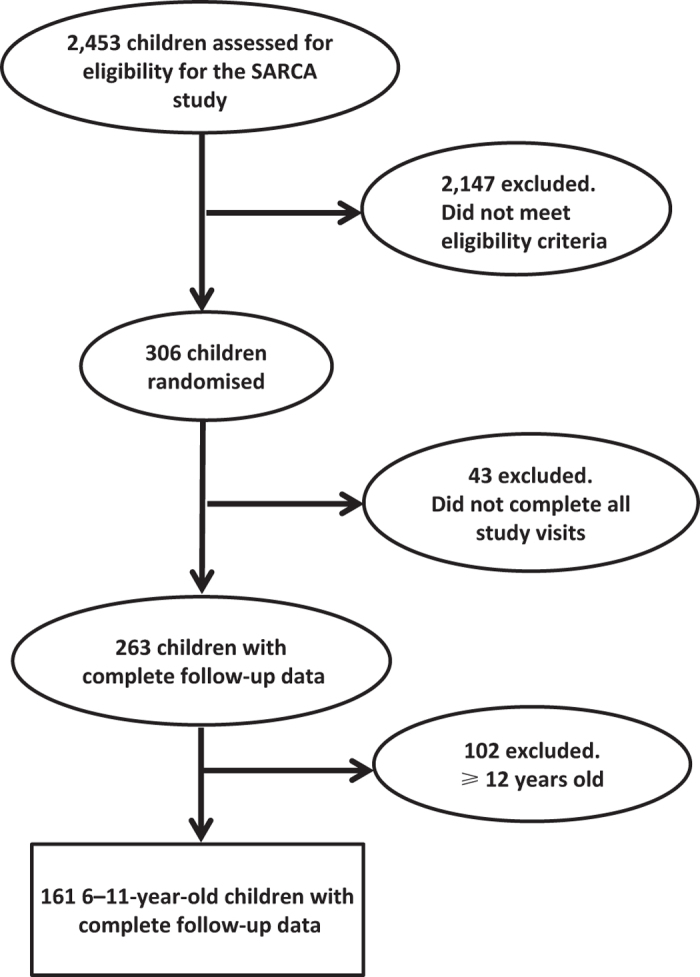
Participant flow.